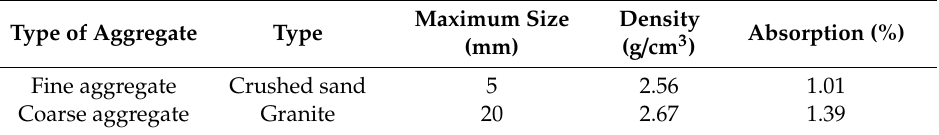
Table 5. Aggregate